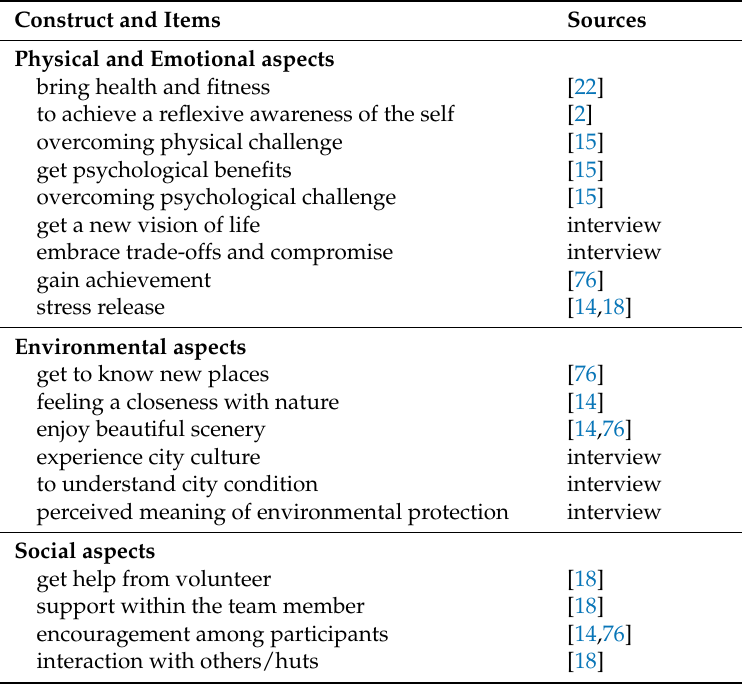
Table 1. Walking experience